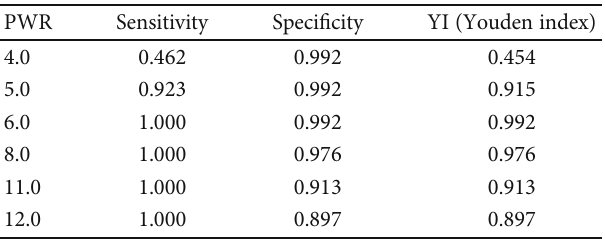
Table 4: Results of diagnostic indicators at di ff erent cuto ff values of